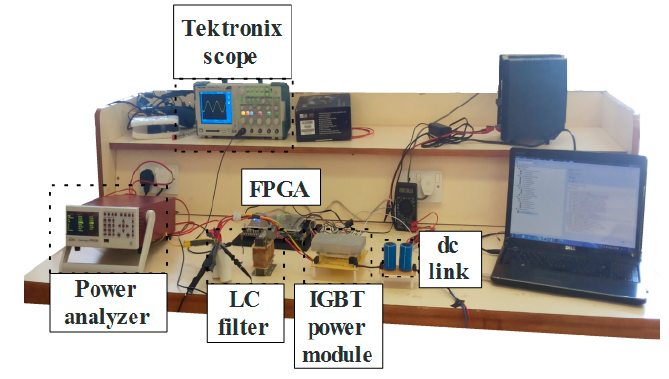
Figure 11. Flowchart of the iterative calculation of junction temperature.